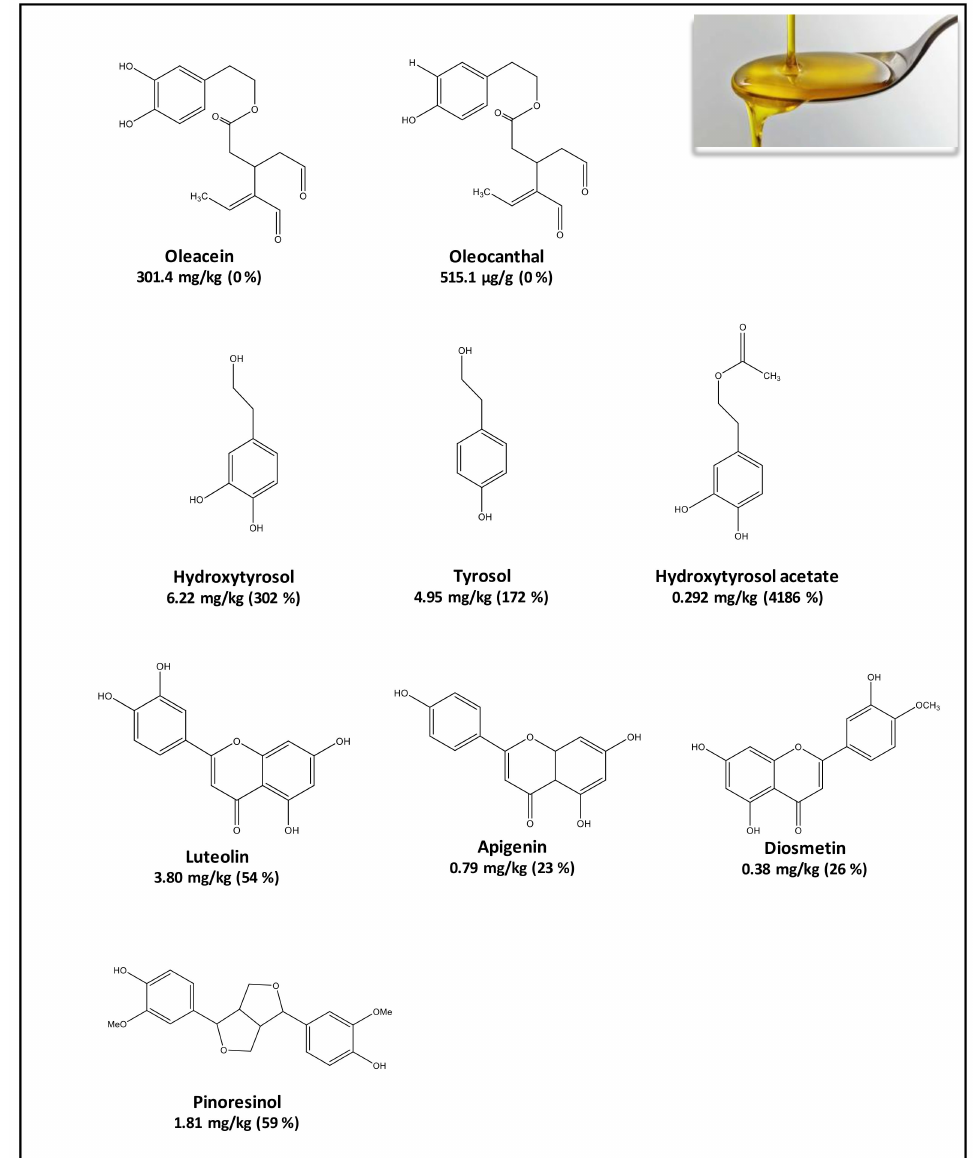
Figure 2. Phenolic compounds determined in EVOO (mg/kg) and their potential bioaccessibility after in-vitro digestion (%). Data taken from Reboredo-Rodr í guez et al.